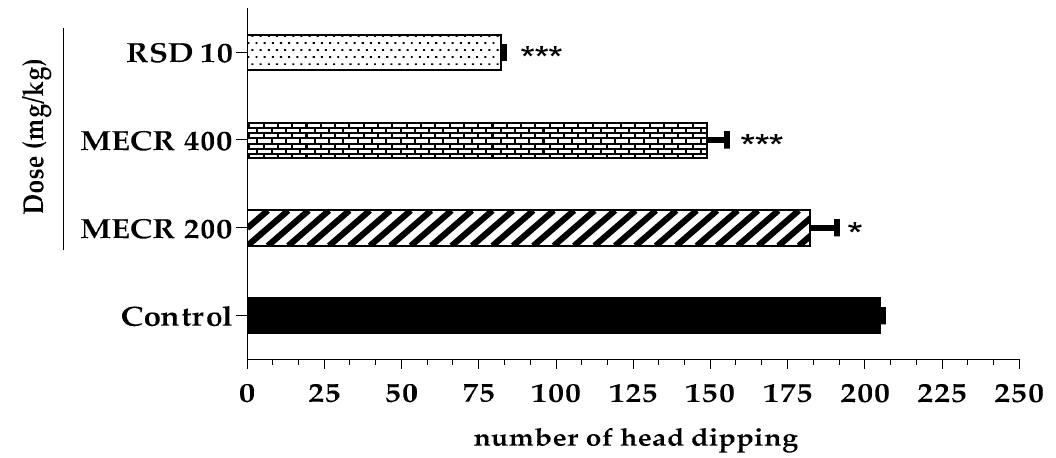
Figure 4. The effect of methanol extract of Cuscuta reflexa (MECR) in tail suspension test in mice. Values are expressed in mean ± SEM (n=6). *p < 0.05 and ***p < 0.001 compared to control (Dunnett’s test). RSD: reference standard drug (Imipramine hydrochloride, 10 mg/kg).